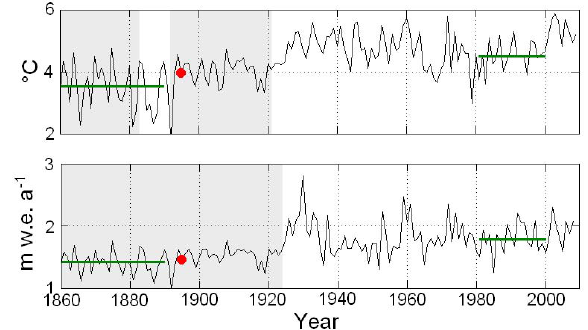
Fig. 8. Mean annual temperature (upper panel) at Hólar in Hornafjörður and precipitation (lower panel) at Fagurhólsmýri. The gray areas indicate the periods when the time-series were recon- structed. The horizontal lines indicate the average climate for the two baseline periods 1860–1890 and 1981–2000. The dots show the temperature and precipitation in 1895, the first year of the model